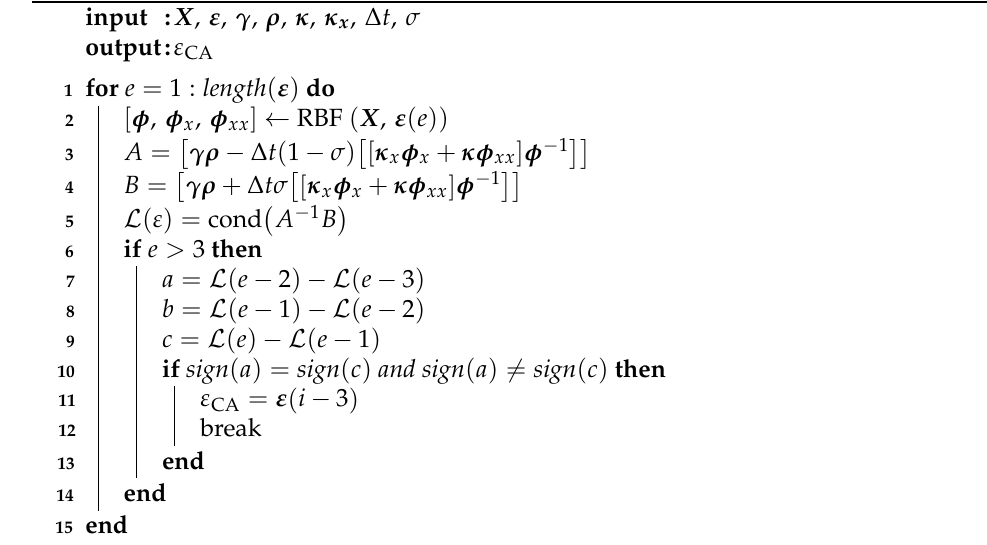
Figure 1. Example of L ( ε ) function with marked good value of the shape parameter ε . Algorithm 1: Pseudocode describing the proposed condition algorithm. X is the vector of collocation points coordinates, ε is a vector of the shape parameter values. The range of ε was selected empirically by trial and